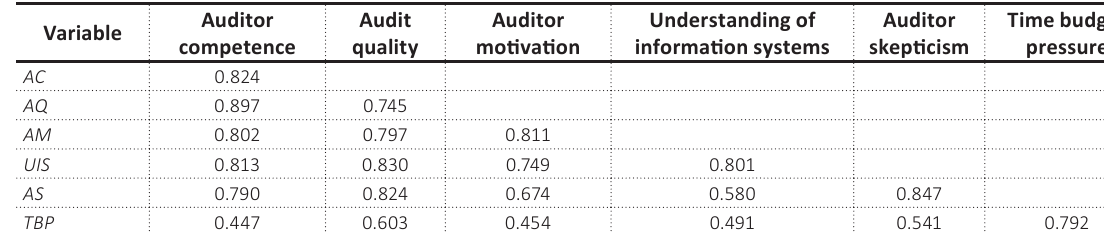
Table 5. Discriminant validity